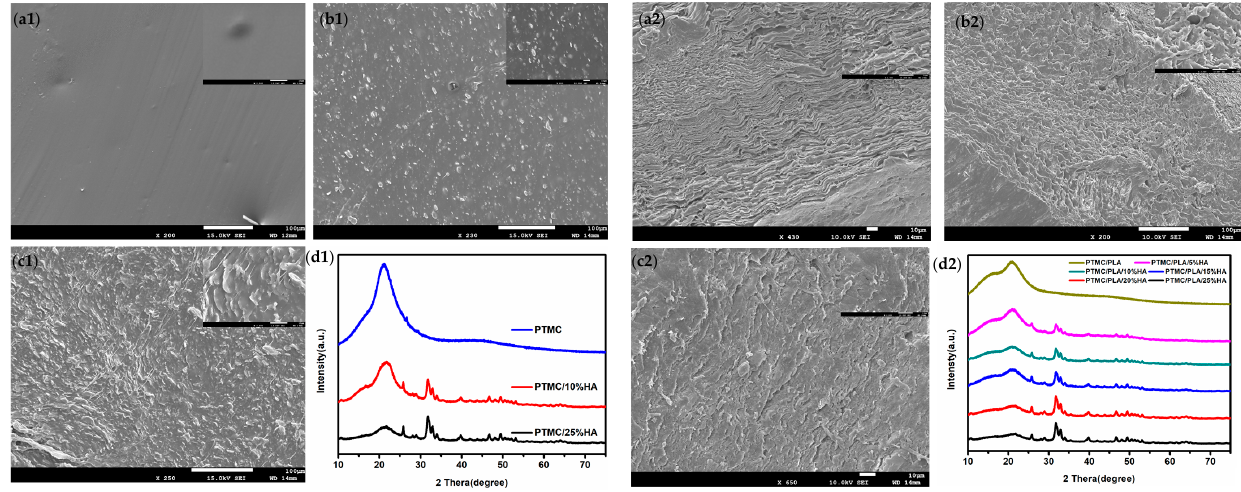
Figure 3. Micromorphology of PTMC/HA and PTMC/PLA/HA scaffold. ( a1 ): PTMC, ( b1 ): PTMC/10%HA, ( c1 ): PTMC/25%HA, ( a2 ): PTMC/PLA, ( b2 ): PTMC/PLA/10%HA, ( c2 ): PTMC/PLA/25%HA); XRD of PTMC/HA ( d1 ) and PTMC/PLA/HA scaffolds ( d2 ).